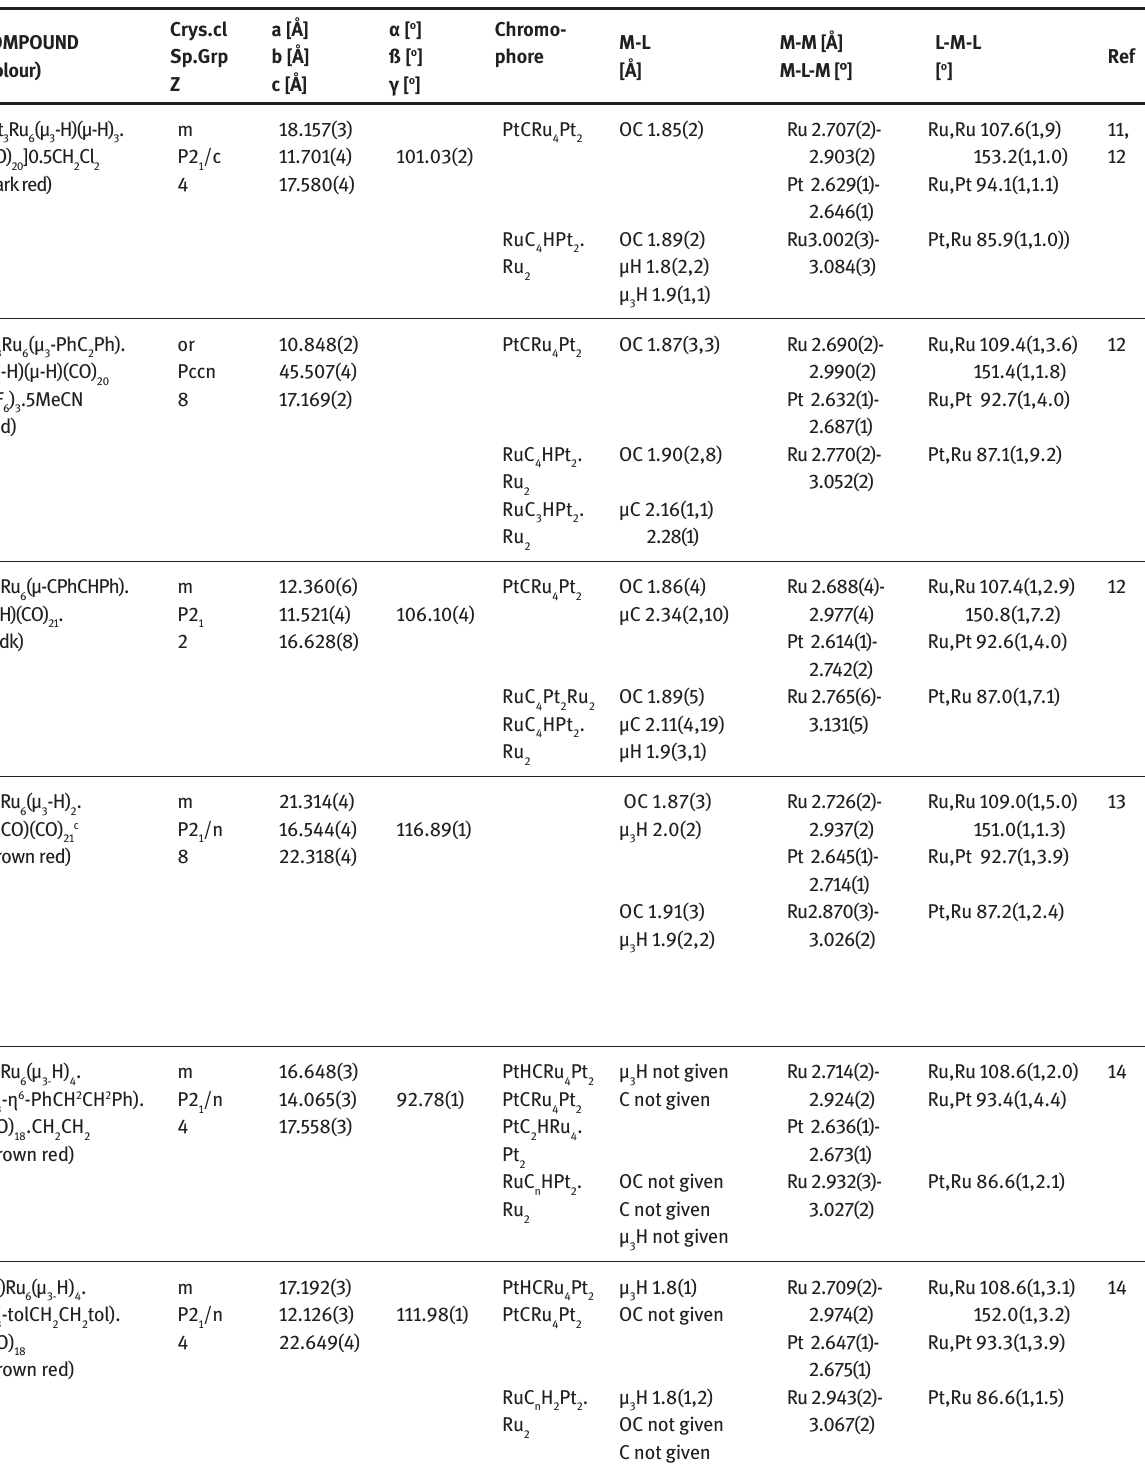
Table 1: Crystallographic and structural data for heterononanuclear platinum clusters a Continued